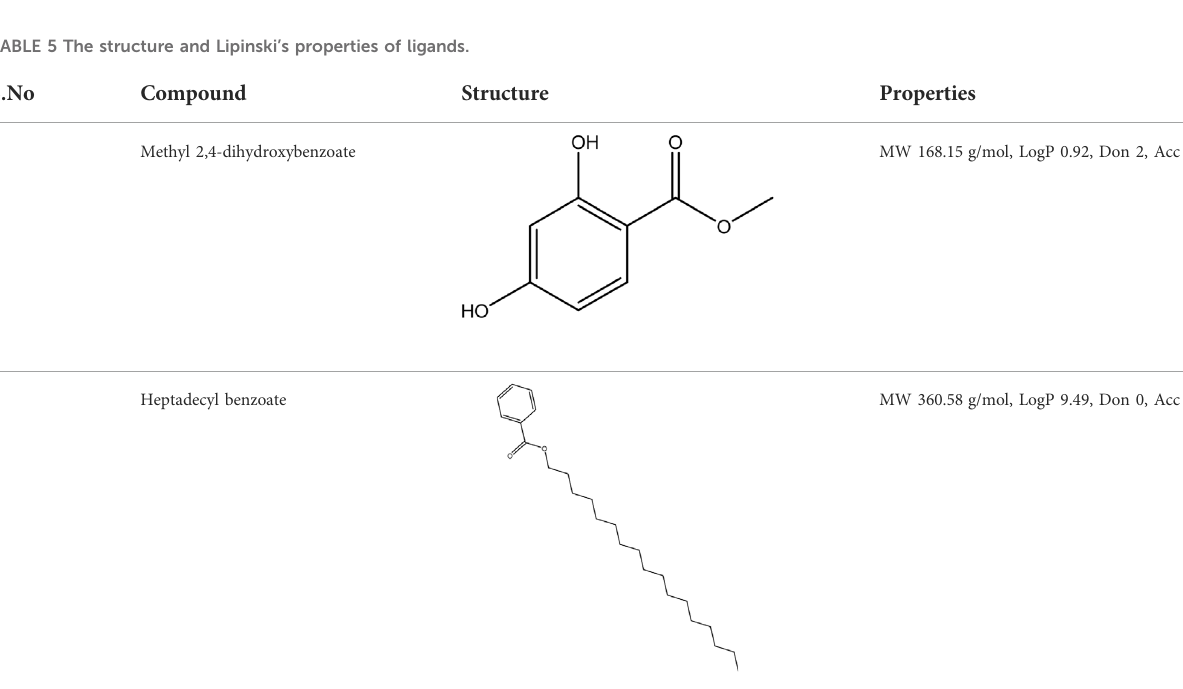
TABLE 5 The structure and Lipinski ’ s properties of